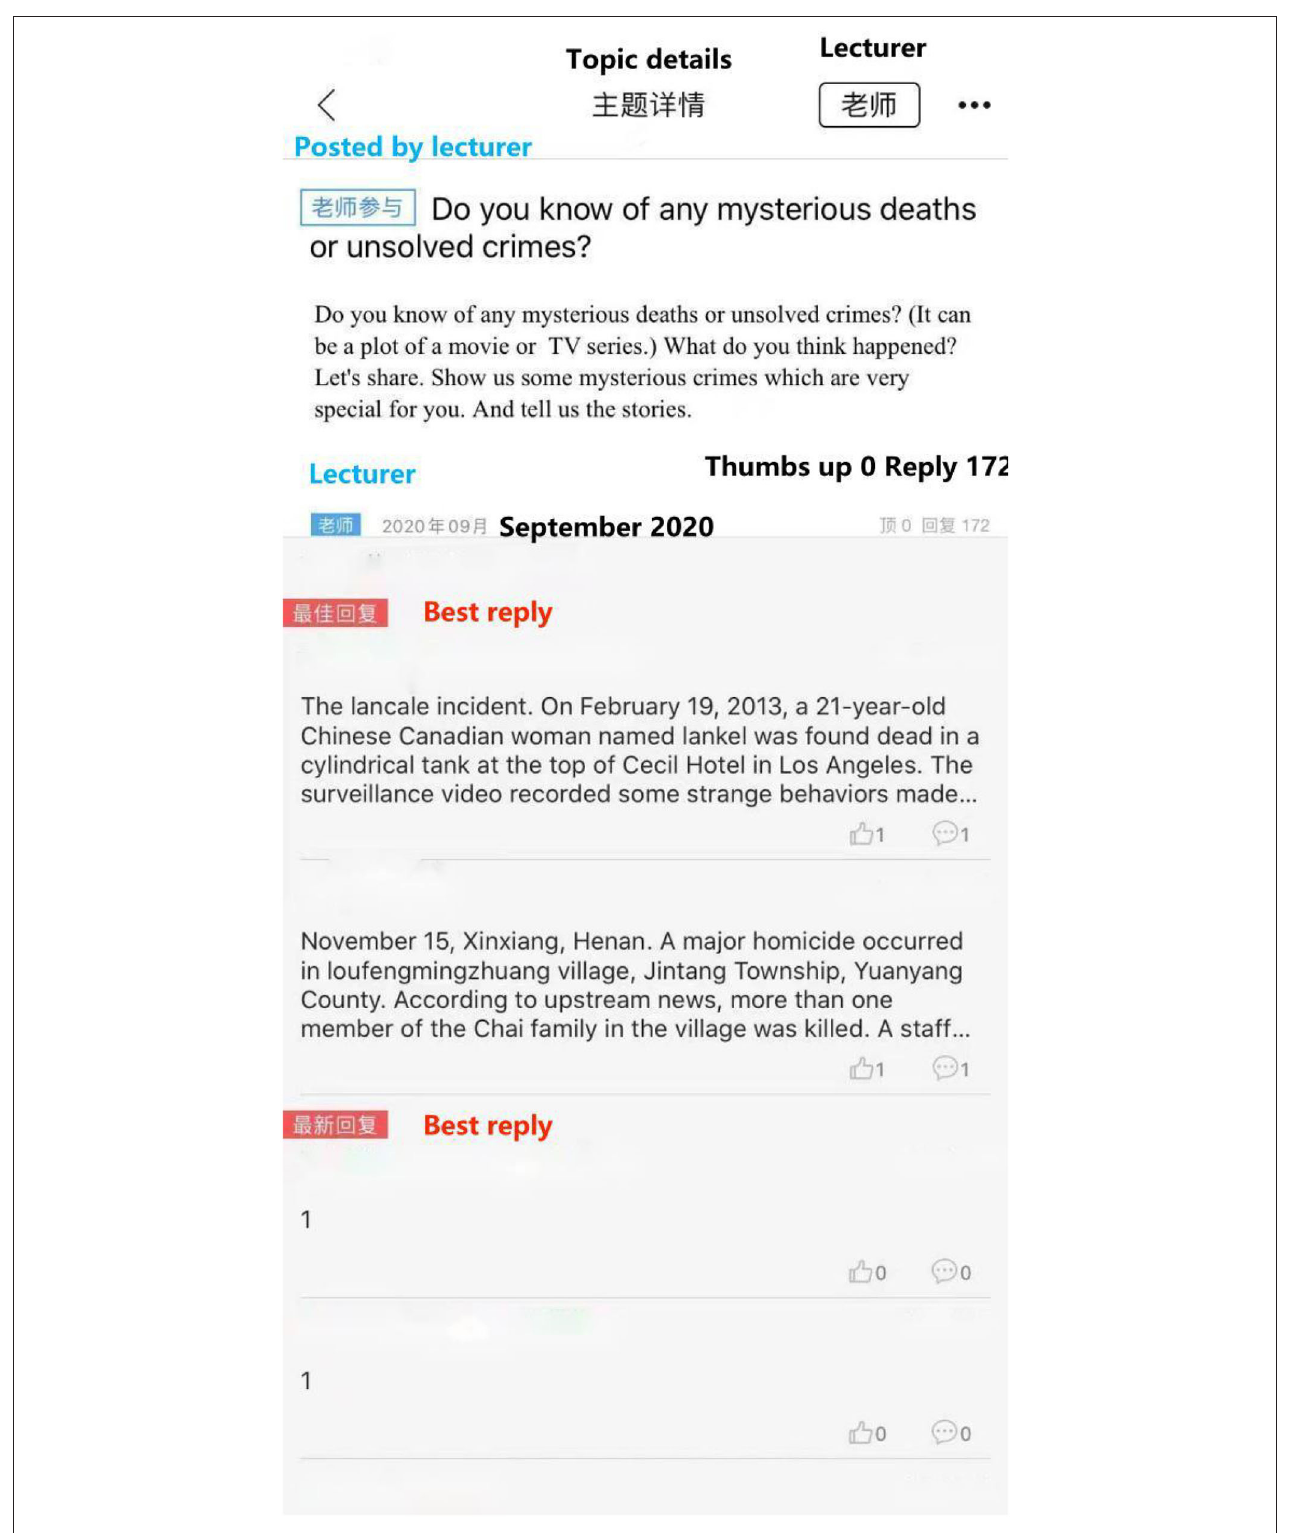
FIGURE 2 | Icourse—Online discussion